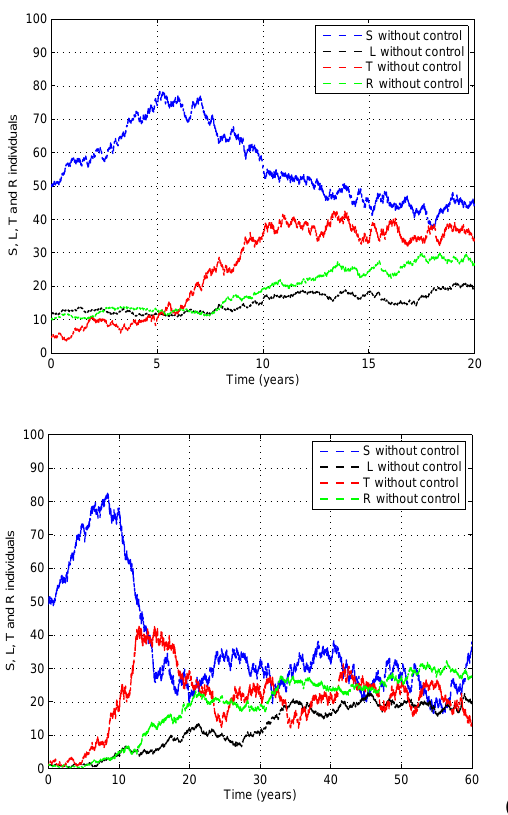
Fig. 2. Numerical Simulations of the model (1) without control (i.e. not depending of u ), showing the asymptotic behavior of the solution when R τ 0 > 1 at different initial con- dition: ( i ) : X 0 = ( S 0 , L 0 , T 0 , R 0 ) = (50 , 12 , 5 , 10) , Λ = 10 , β T = 0 . 8 , τ = 0 . 08 , R τ 0 = 2 . 3710 > 1 and, ( ii ) X 0 = ( S 0 , L 0 , T 0 , R 0 ) = (50 , 1 , 1 , 1) , Λ = 8 , β T = 0 . 9 , τ = 0 . 08 . R τ 0 = 3 . 5565 > 1 .